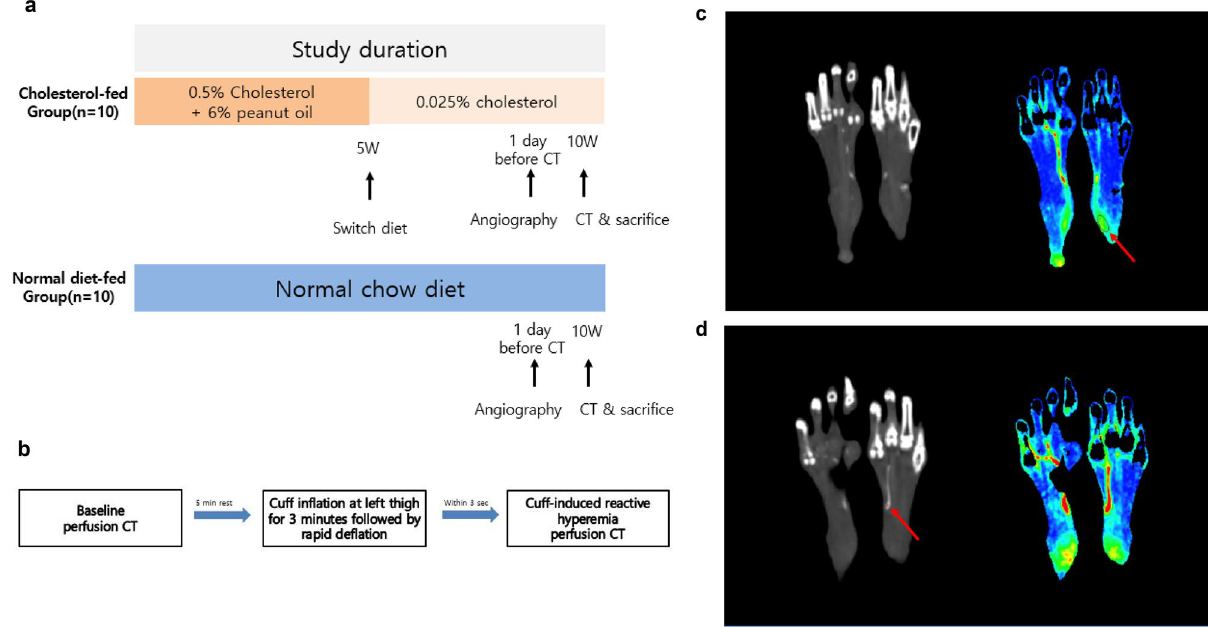
Figure 1. ( a ) Study protocol for cholesterol-fed rabbits. ( b ) Timeline of CT perfusion protocol. ( c ) Color-coded perfusion map reconstructed from perfusion CT. Microperfusion values were measured at selected region of interest (red arrow) in the hyperperfusion tissue in the rabbit’s heels on reconstructed image. ( d ) Color-coded perfusion map reconstructed from perfusion CT. CT value of tibial artery was measured on reconstructed CT image (red dot and red arrow).